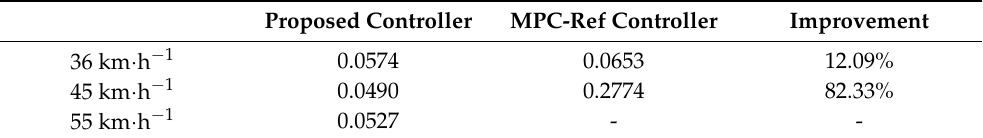
Figure 15. Trajectory tracking results at 55 km · h − 1 ; ( a ) Driving path; ( b ) Lateral tracking error. Table 4. RESM of the trajectory tracking Table 5. RESM of the trajectory tracking error.